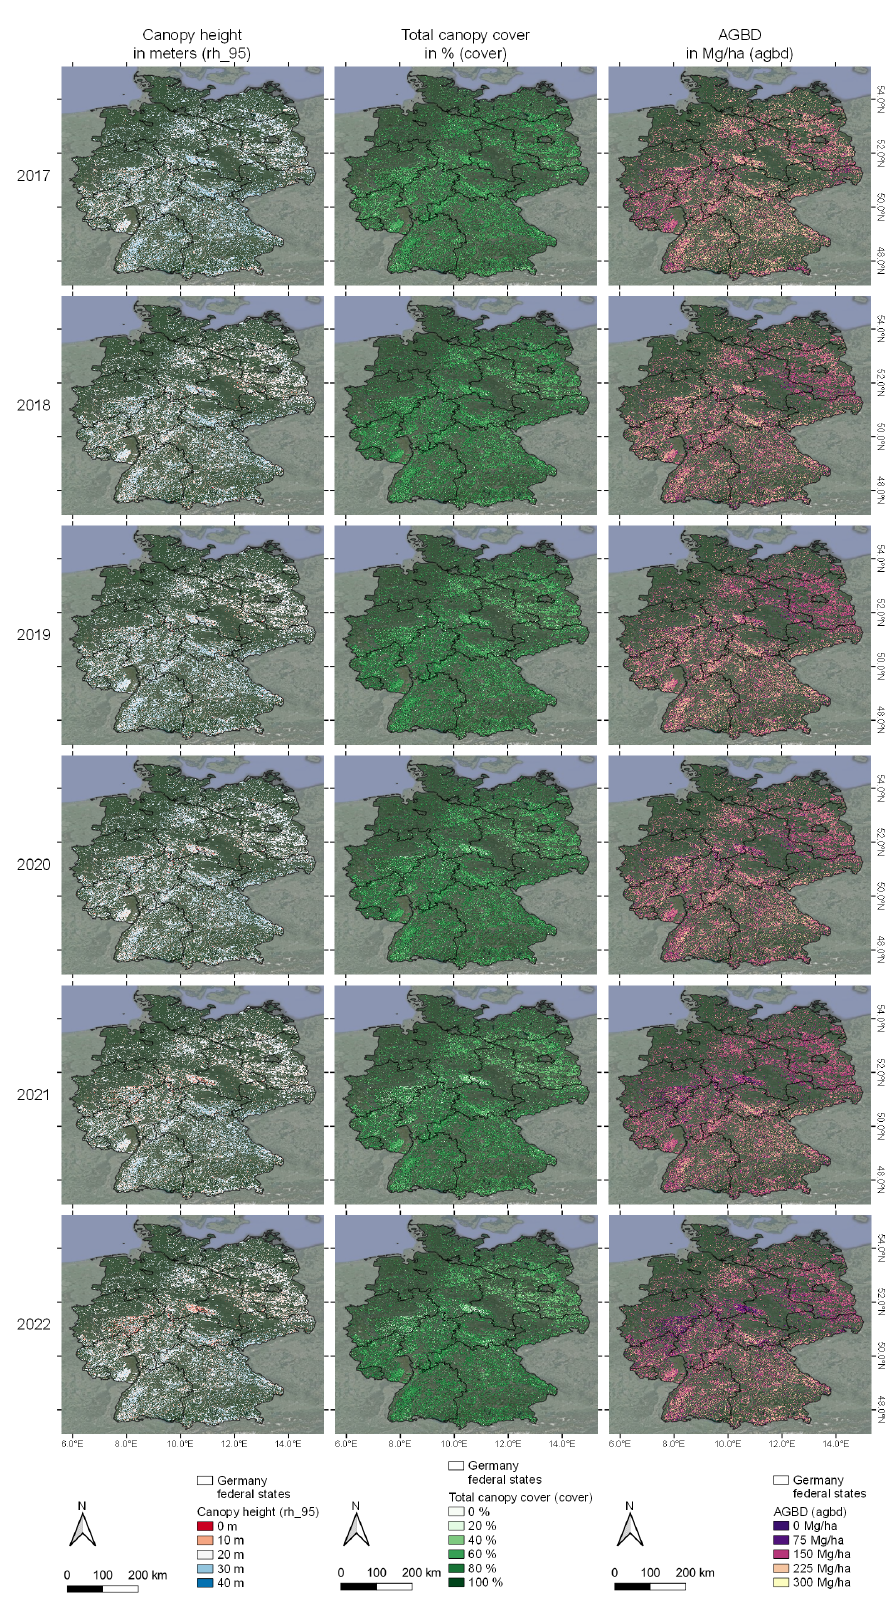
Figure 6. Forest structure from 2017 to 2022 for Germany. The forest areas in the center and western parts of Germany present a declining overall forest structure, i.e., low canopy heights, sparse canopy covers and low AGBD in